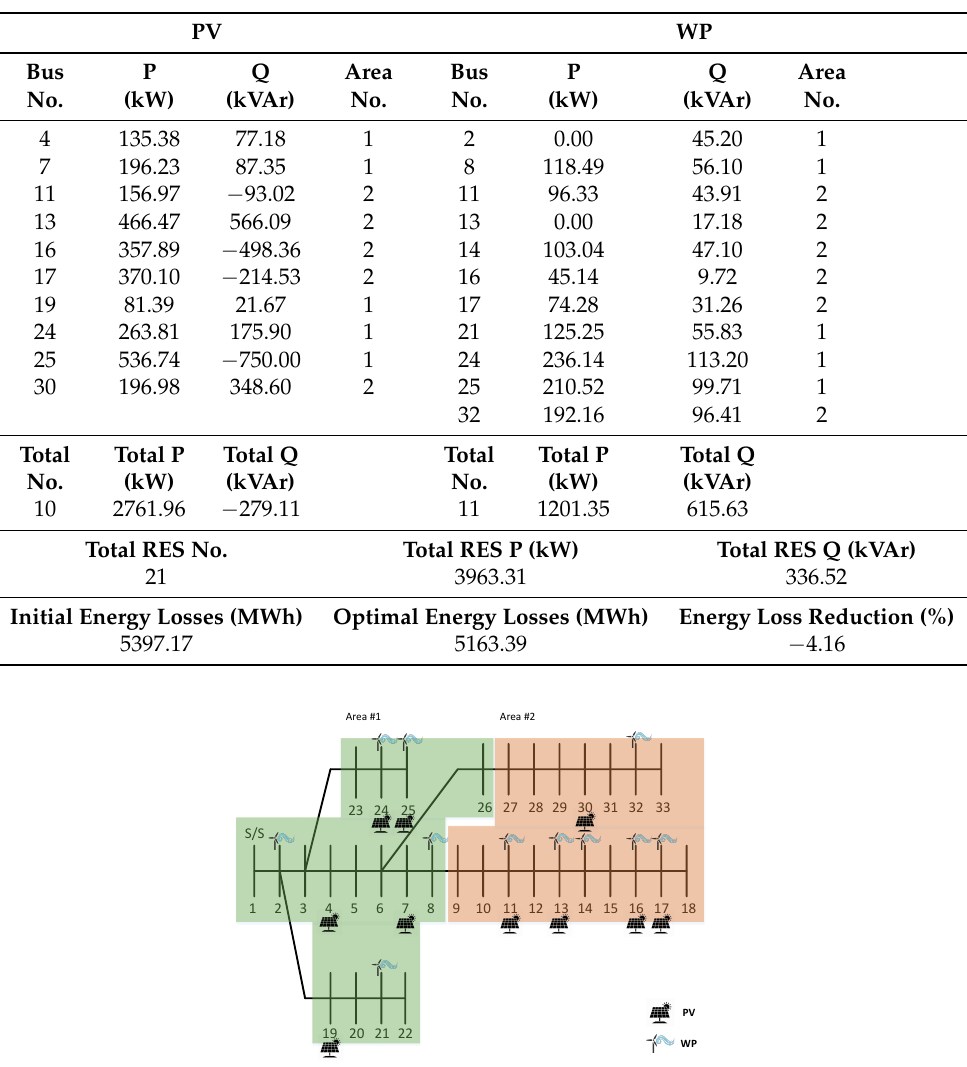
Figure 26. Snapshot Approach—50% Value—Scenario #2 solution. Table 17. Snapshot approach—50% value—Scenario #3.